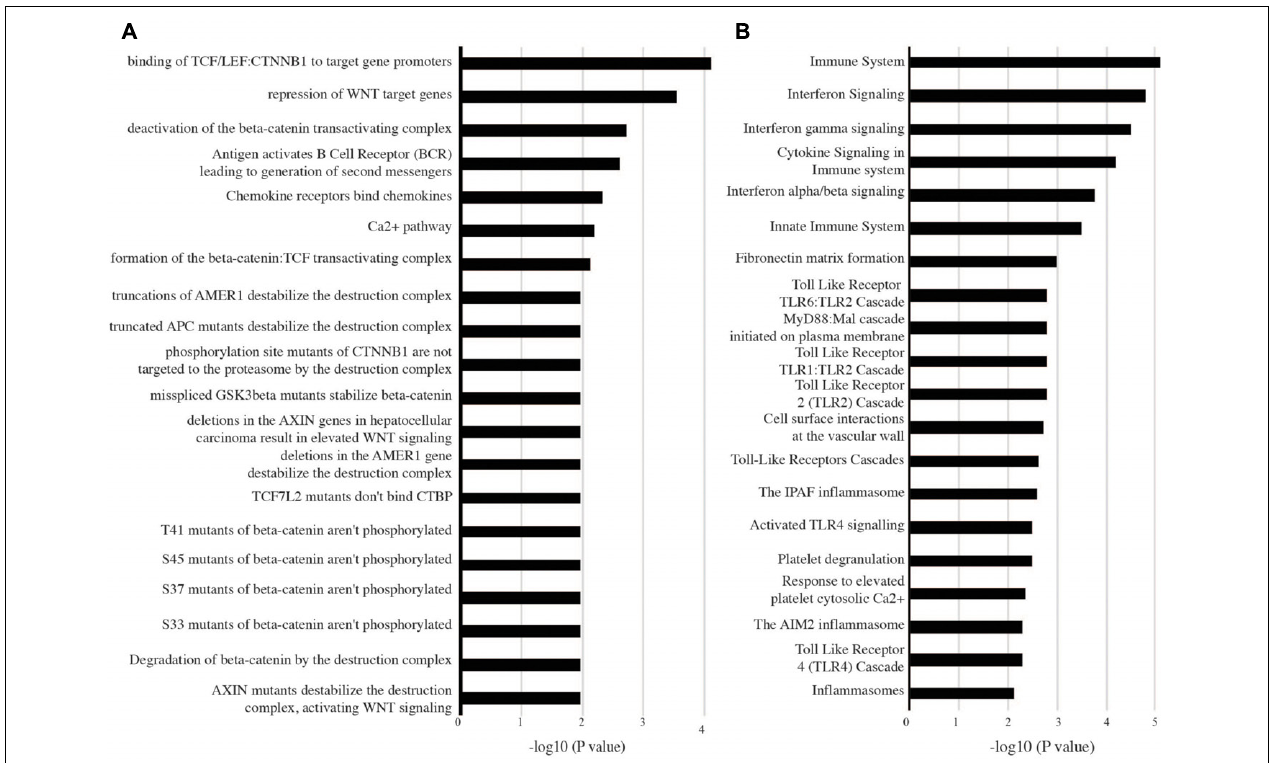
FIGURE 4 | Biological pathways enriched in both adult and childhood tuberculosis (active TB versus LTBI). High confidence genes differentially expressed (1.5-fold change and adjusted p -value < 0.05) in both adults and children were analyzed with InnateDB to identify enriched pathways. (A) Pathways downregulated and (B) pathways upregulated in active